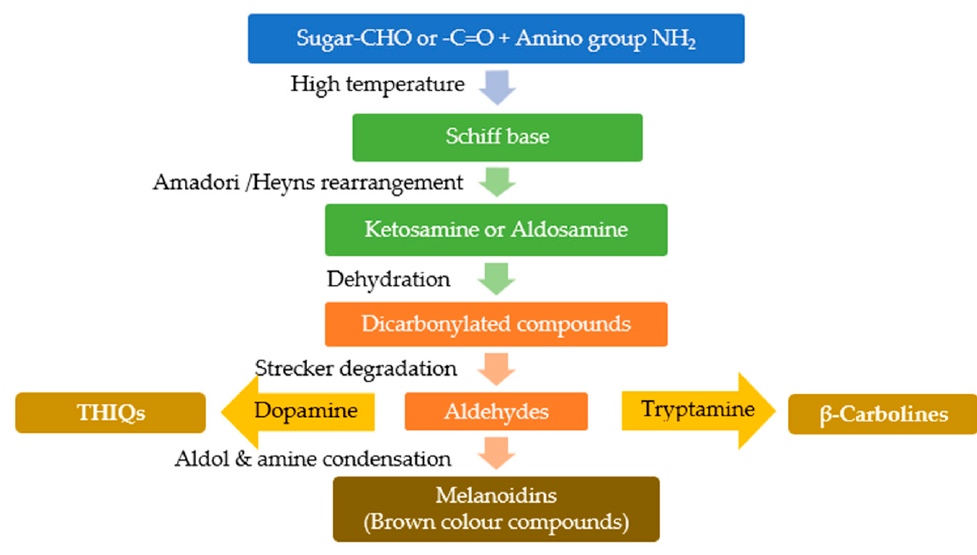
Figure 1. Suggested pathway for the formation of β -carbolines and THIQs through the products of Maillard reaction, as a result of condensation of aldehydes product of Strecker degradation with dopamine or tryptamine.